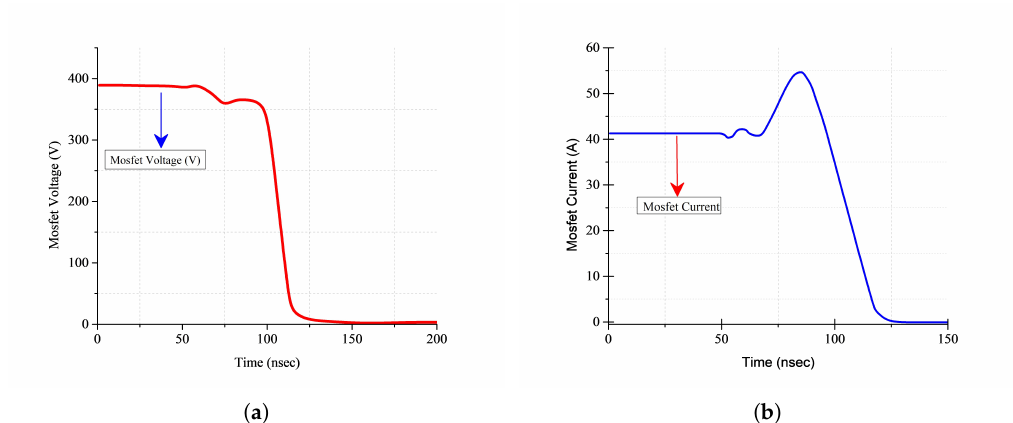
Figure 22. Switching transients of the SiC converter simulation: ( a ) switching voltage and ( b ) current. Table 5. Calculated efficiency and loss. Si IGBT SiC